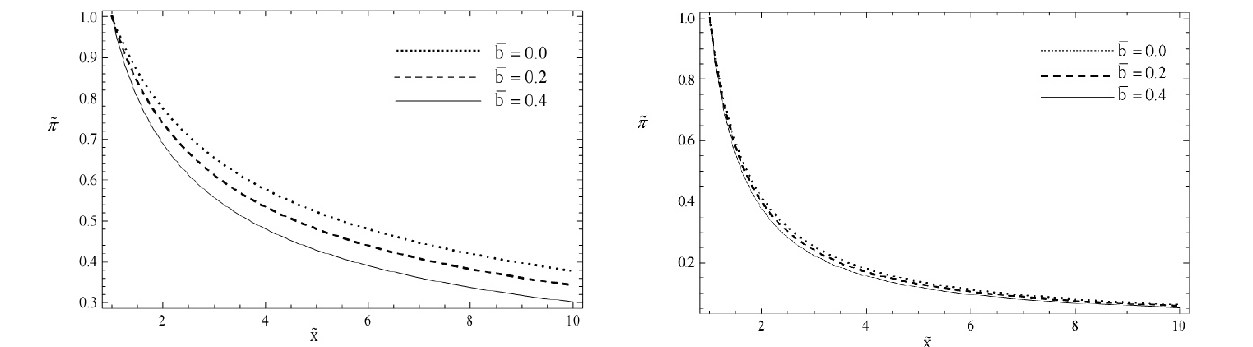
Figure 3. The decay behavior of shock strength ( ˜ π ) for m = 0 , ω = 0 . 5 and γ = 5/3.